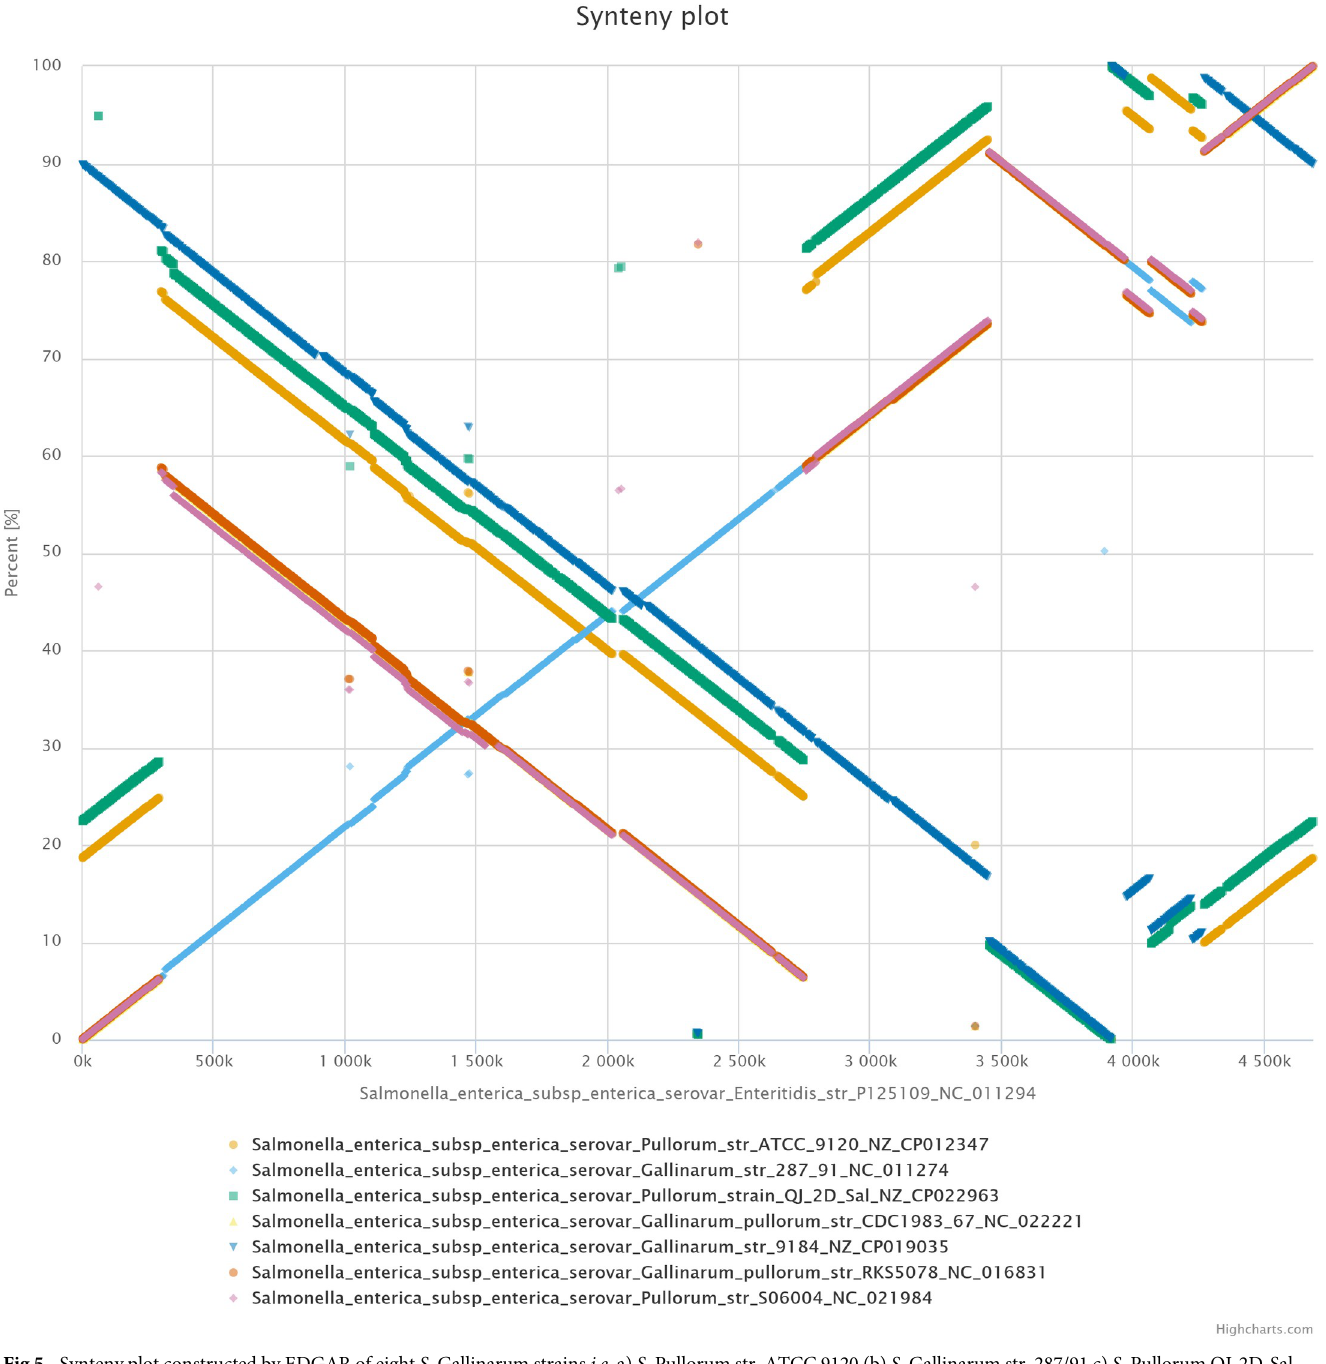
Fig 5. Synteny plot constructed by EDGAR of eight S . Gallinarum strains i . e . a) S . Pullorum str. ATCC 9120 (b) S . Gallinarum str. 287/91 c) S . Pullorum QJ-2D-Sal (d) S . Gallinarum/Pullorum str. CDC1983-67 (e) S . Gallinarum str. 9184, (f) S . Gallinarum/Pullorum str. RKS5078 (g) S . Pullorum str. S06004 against the reference of S . Enteritidis str.